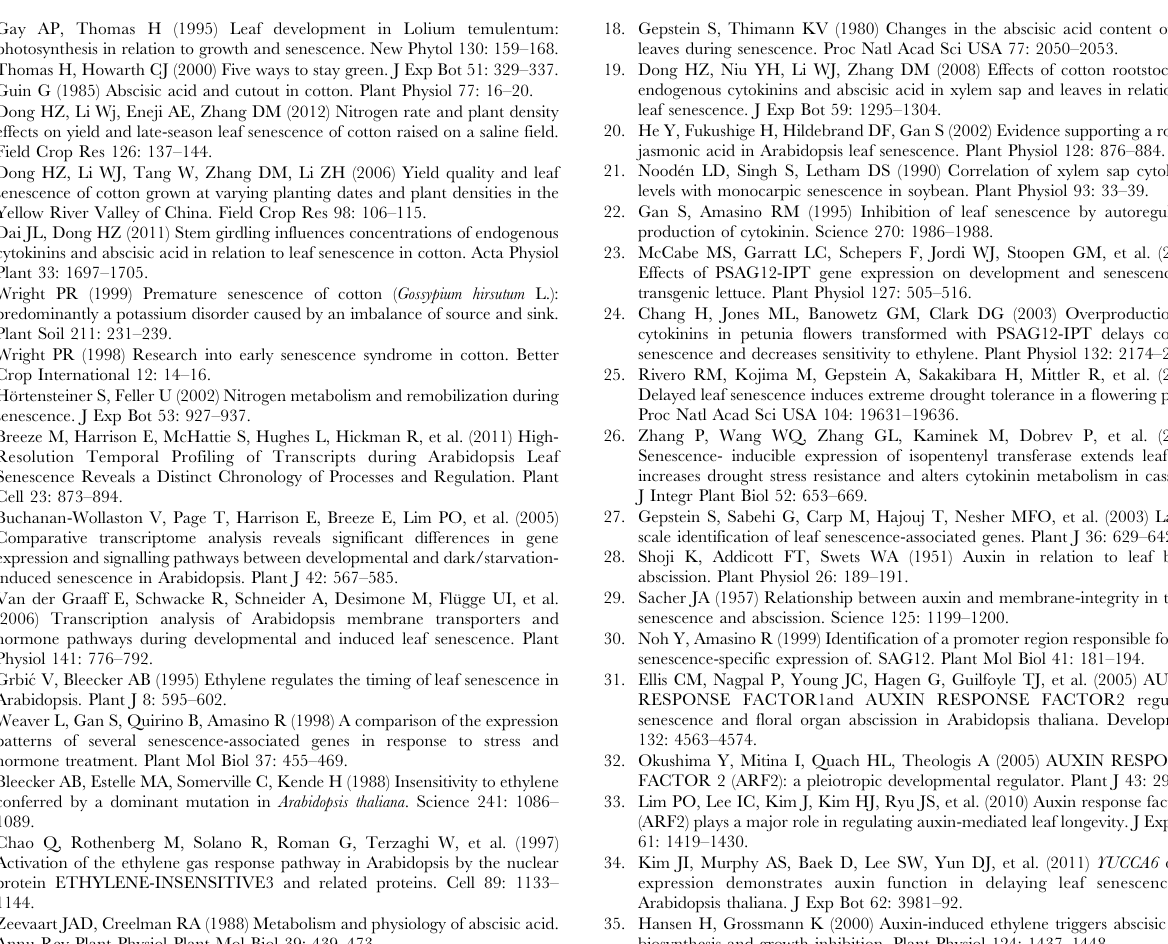
Figure S1 Overview of the short-read based transcrip- tome analysis approach for non-model organisms. Mapping is an option only if a suitable reference genome is available; otherwise FASTA (or FASTQ) sequences must be used [54]. (TIF) Figure S2 Primers used for RT-PCR analyses. (TIF) Figure S3 Chlorophyll (Chl) content and net photosyn- thetic (Pn) rate of the fourth leaf from the apex on the main-stem at 65–110 d after planting. Values are means 6 SD (n= 4). Initial flowering, peak flowering, peak boll-setting, and initial boll-opening occurred at 65, 80, 95, and 110 d after planting.